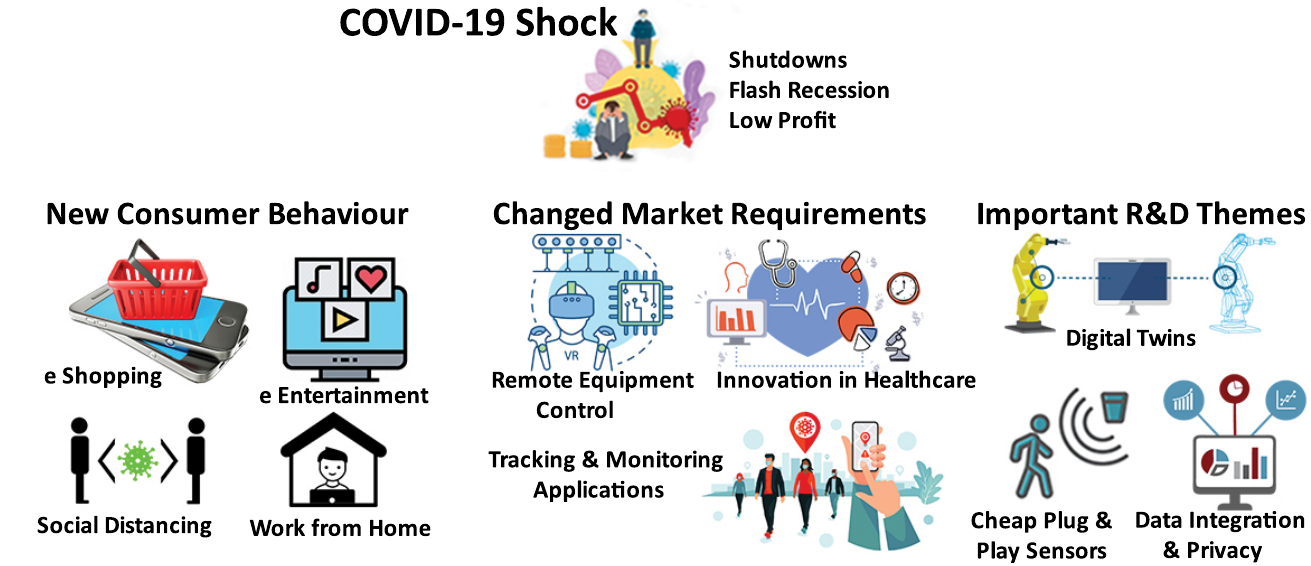
Figure 1. An example of COVID-19’s Impact on IoT Research and